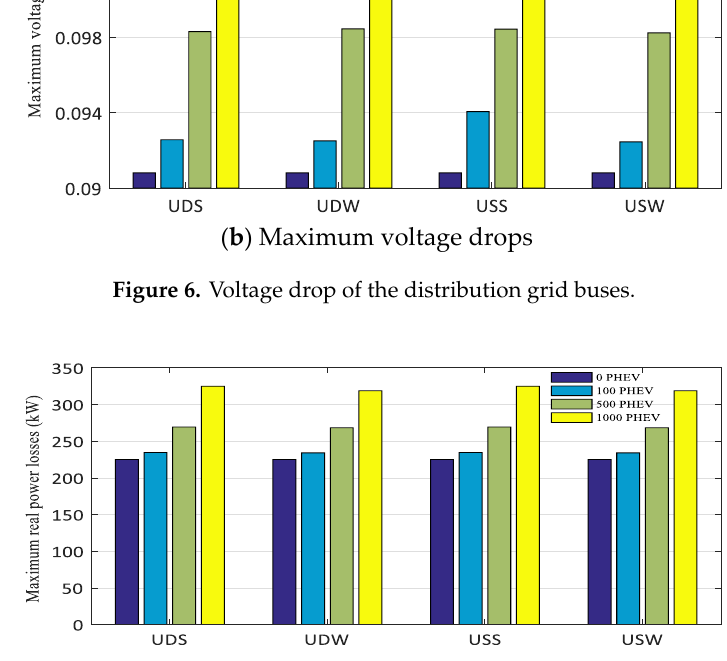
Figure 7. Maximum total active power losses in the distribution grid lines.